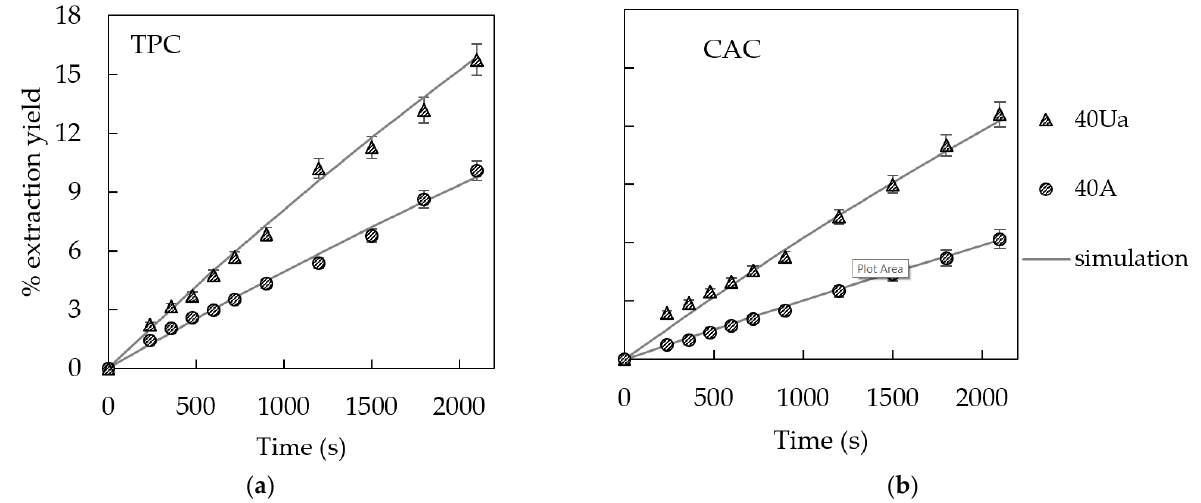
Figure 2. Experimental and simulated extraction yield curves of ( a ) total polyphenol content (TPC) and ( b ) chlorogenic acid content (CAC) from artichoke stem slabs (1 cm thickness) at 40 °C with agitation (A, 100 rpm) and acoustic assistance (Ua, 200 W/L).